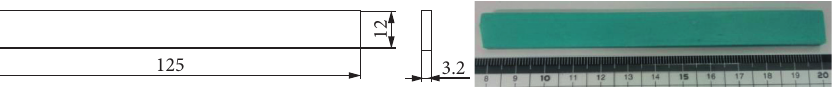
Figure 3: Sample size for bending strength testing.